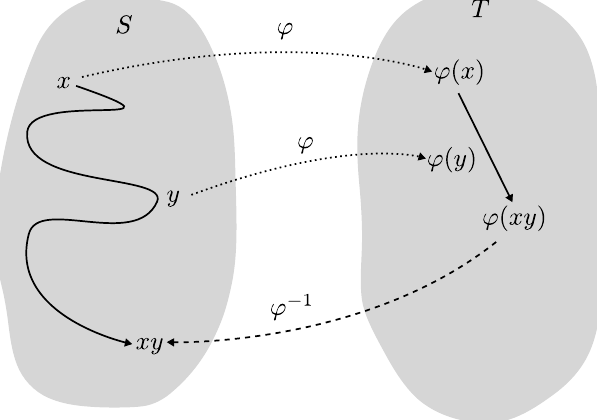
Figure 3. Schematic view of a morphism. S is the source semigroup, in which getting from x to xy is a slow or expensive operation. Mapping the computation over to the target semigroup T by ϕ the computation of ϕ ( xy ) is easy, and we can map the result back. The source can be a long pencil and paper arithmetic computation, while the target can be an electronic